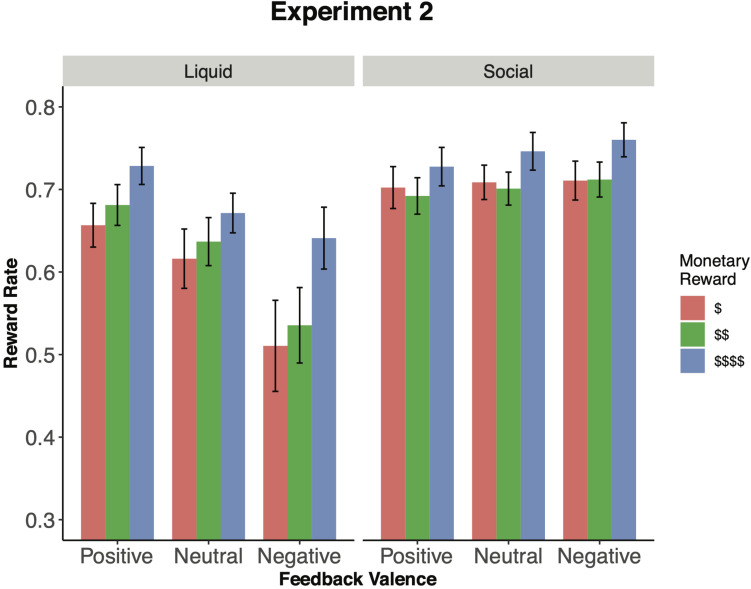
Incentive integration effects by experimental manipulation (Experiment 2). This figure shows reward rate by monetary reward level and feedback (i.e., liquid, social). Participants showed a main effect of monetary reward and feedback during both the social and liquid feedback sessions. However, the effect of feedback was not as strong for social relative to liquid feedback. Error bars represent 95% confidence intervals around the mean.